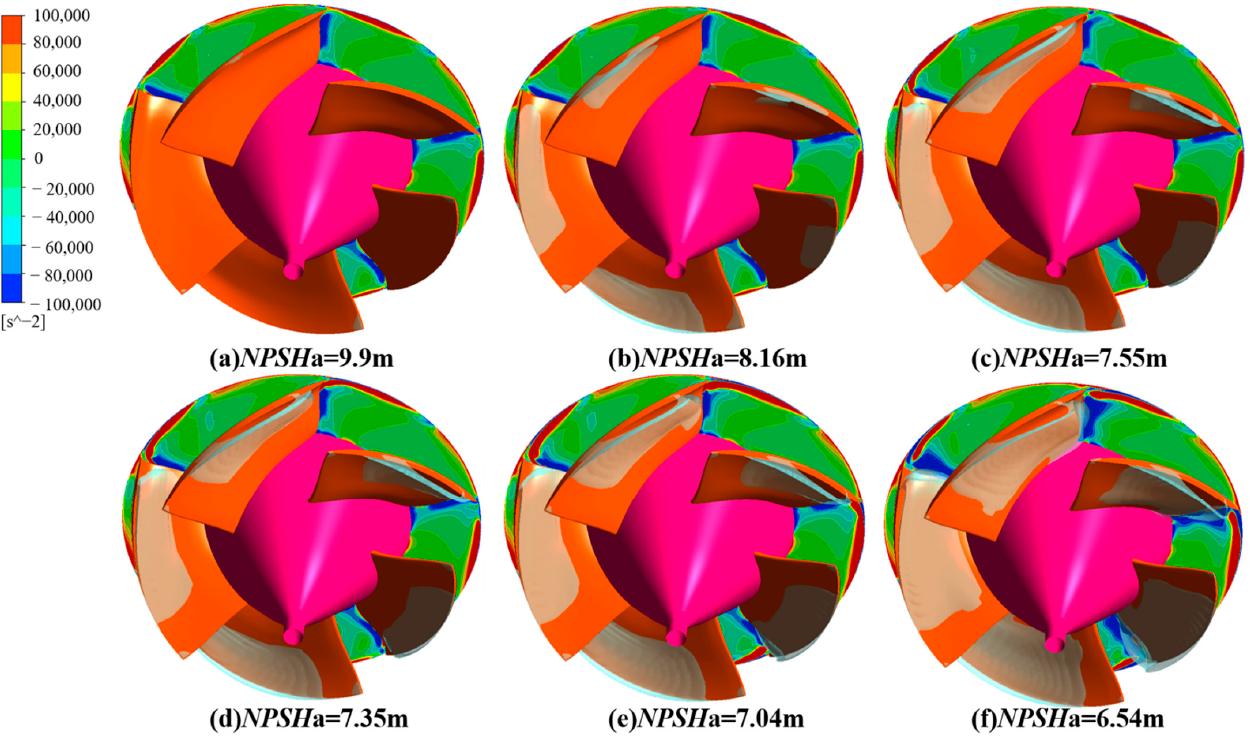
Figure 14. The cavitation region and contours of the vortex stretching term on the spanwise section near TE.